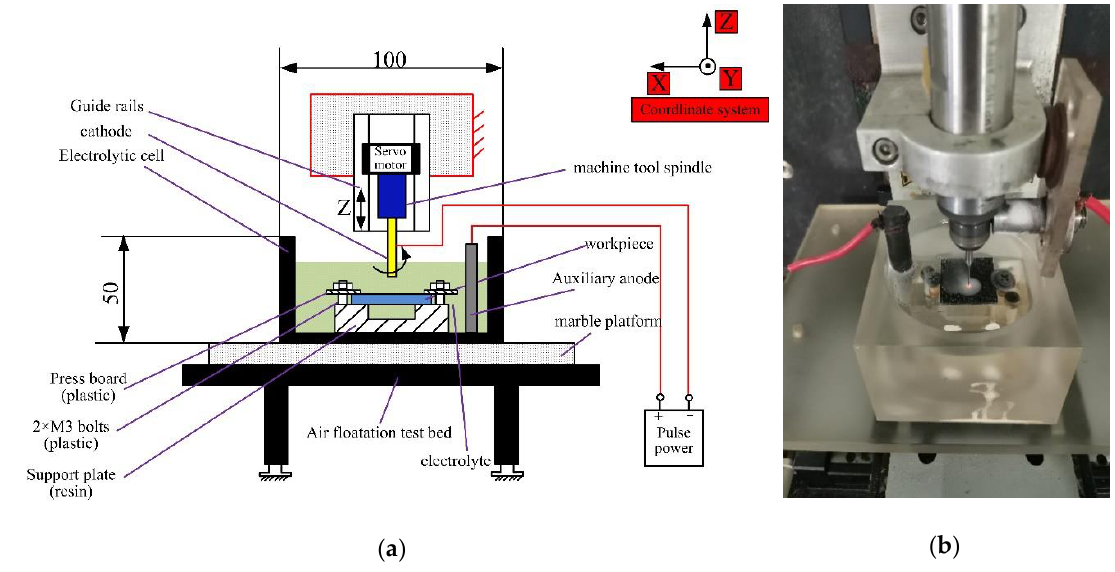
Figure 2. ECDM experimental system: ( a ) the schematic diagram; and ( b ) the actual view.